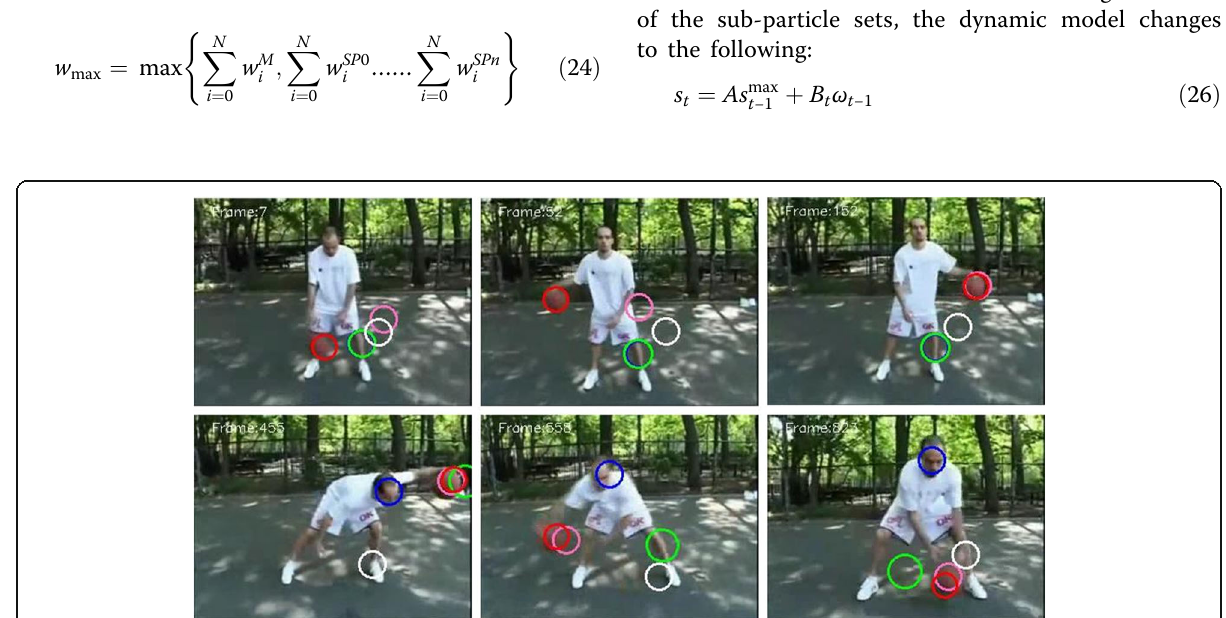
Fig. 14 The tracking results for the video “ basketball_1 ” using CAM-Shift (white), PF (blue), VAPF (green), M-PF (pink), and the proposed tracker (red). Particle number N = 250